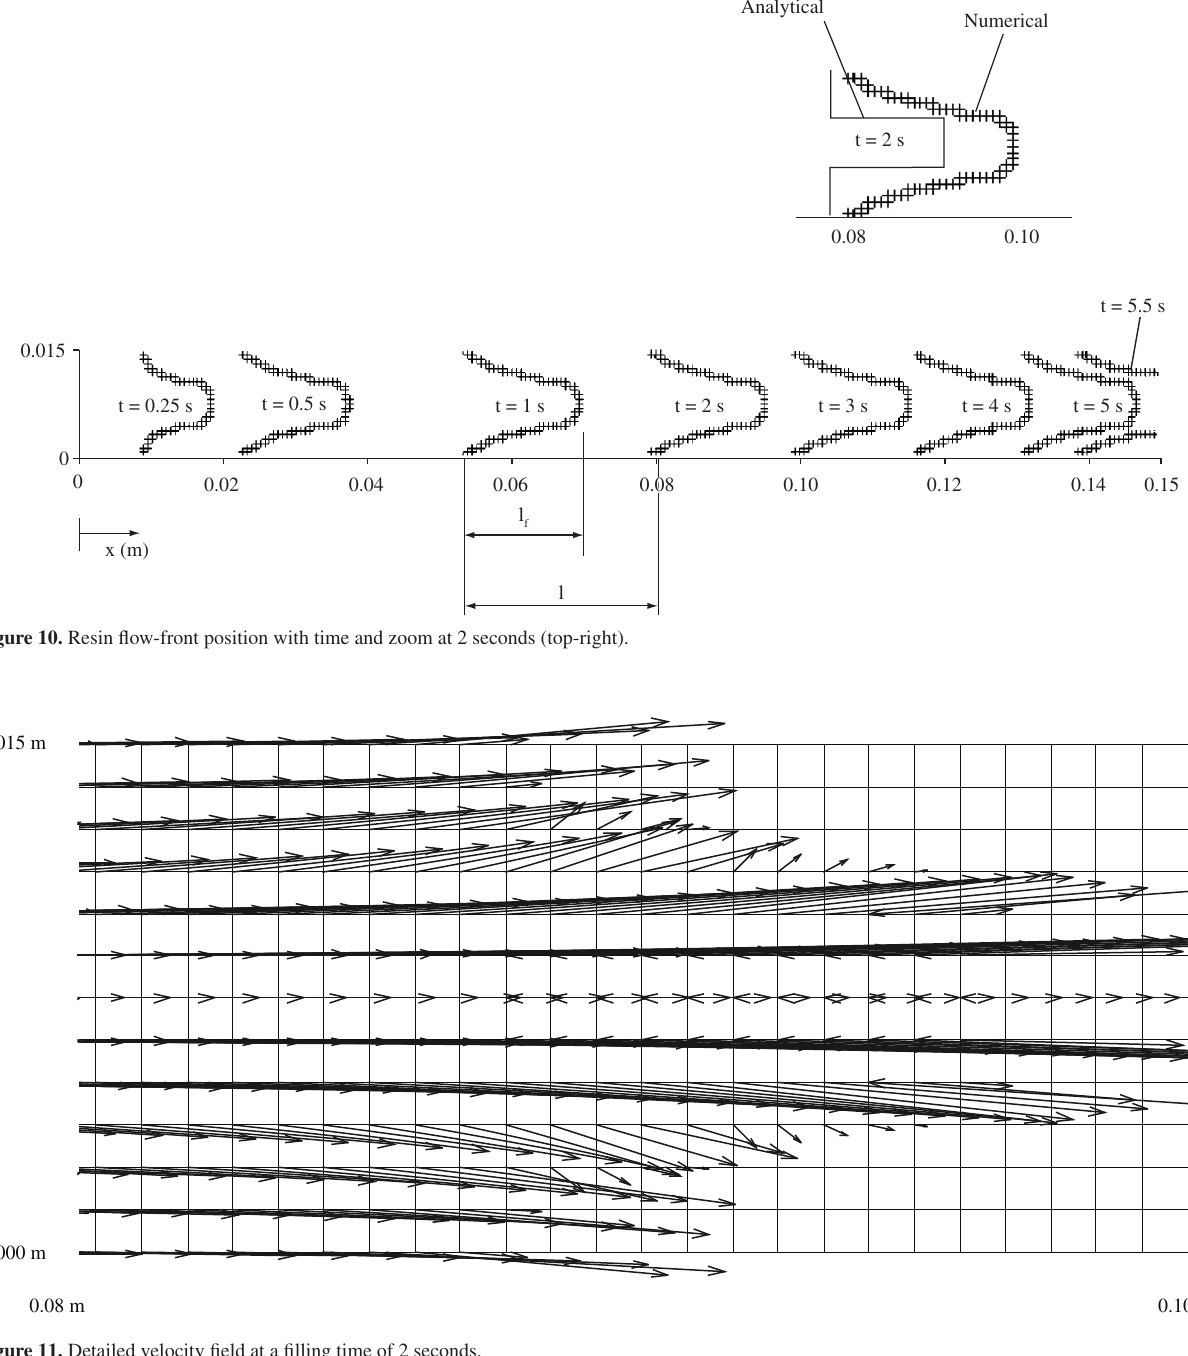
Figure 11. Detailed velocity field at a filling time of 2